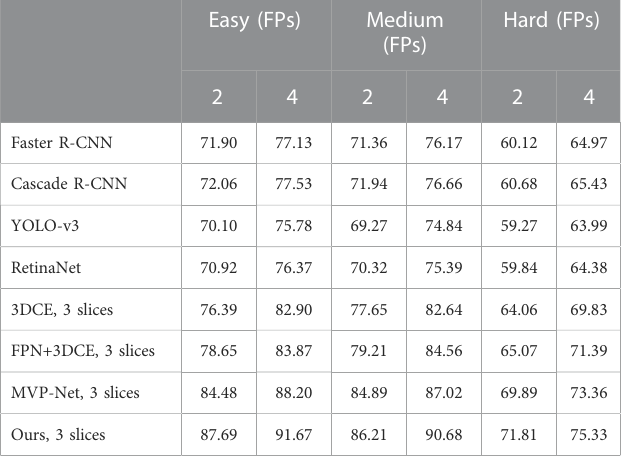
TABLE4Sensitivity(%)at2and4falsepositivesperimageonDeepLesion ’ sthree subsets of detection dif fi culty. Easy (FPs)